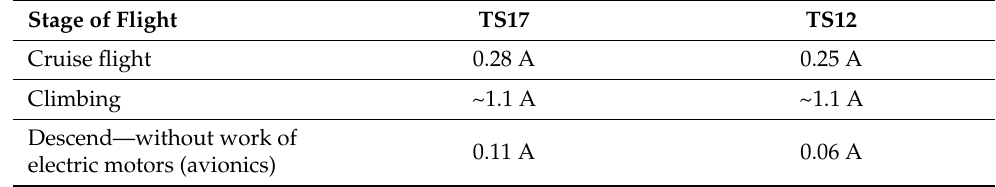
Table 7. Discharging currents during the